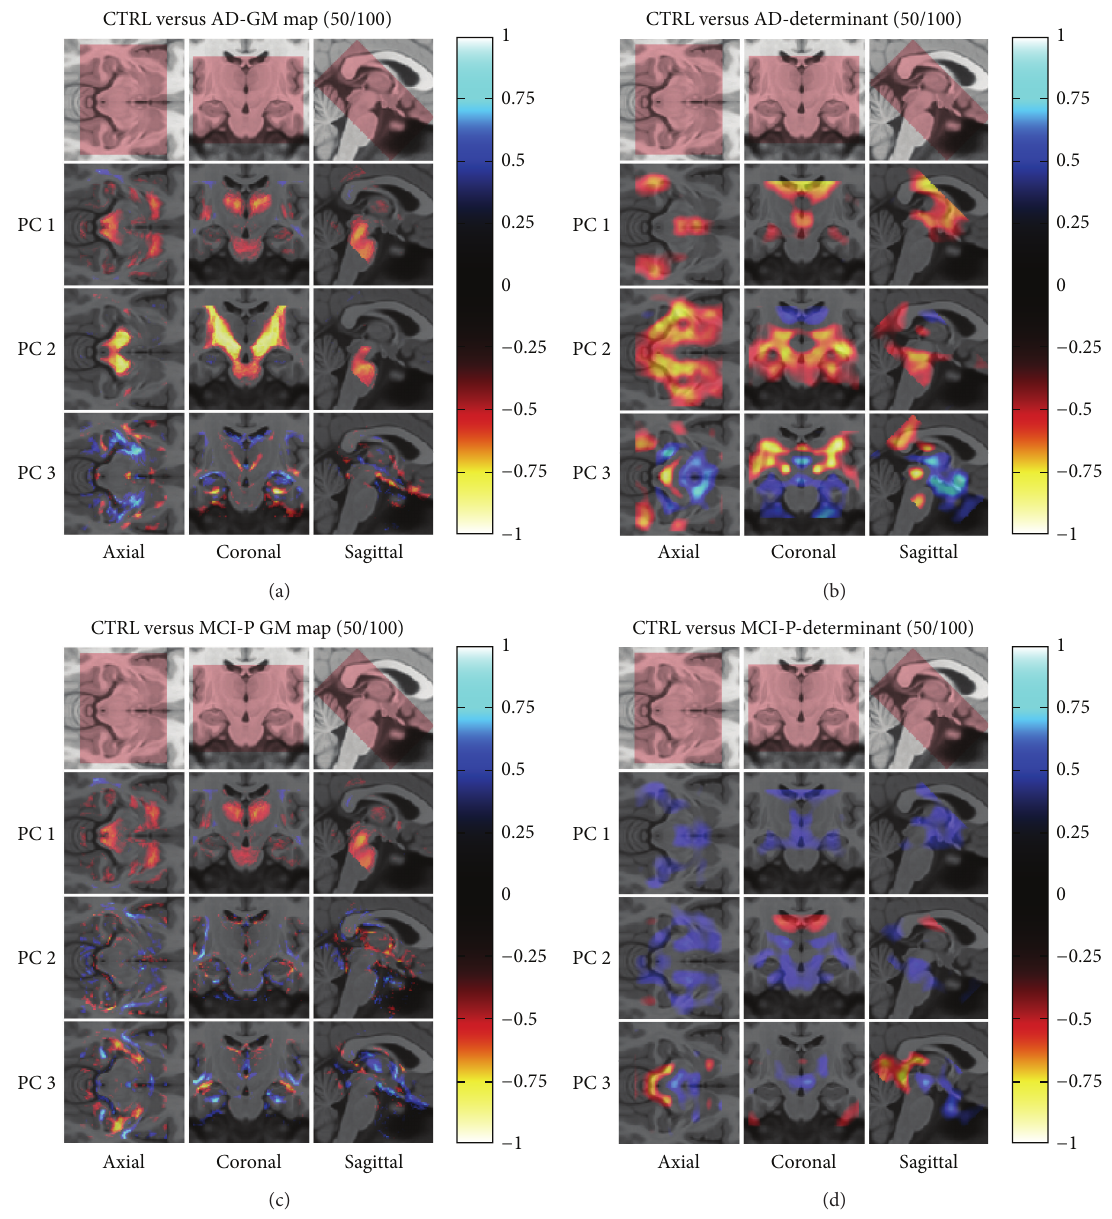
Figure 4: Significant structural differences within the medial temporal lobe related to the discrimination task between (a, b) CTRL versus probable AD and (c, d) CTRL versus MCI-P. Left images represent grey matter concentration differences, while right images represent deformation differences. For each map, we present the covarying voxels associated with the top three eigenvectors in each discriminating function, color-coded with respect to their negative or positive distance from the center and normalized to the maximum absolute value in the